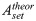
The controllers investigated in this study.Reaction orders are with respect to E. The reaction between E1 and E2 in the antithetic controller is an overall second-order process. The controllers behave ideal in the sense that they for step-wise changes in A and/or V, are able to keep A precisely at their defined theoretical set-points Asettheor.